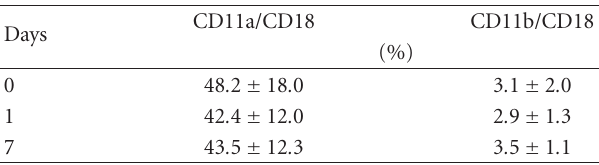
Table 4: Expressions of lymphocyte CD11a/CD18 and neutrophil CD11b/CD18 before and after the